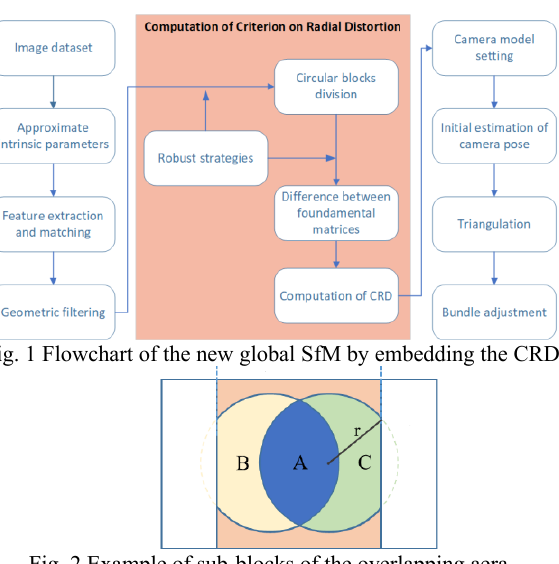
Fig. 2 Example of sub-blocks of the overlapping aera For the computation of CRD in one matched image pair, point correspondences are already known. Then the matching points in different ring sub-blocks; finally, the difference between these fundamental matrices were used to reflect the radial distortion.